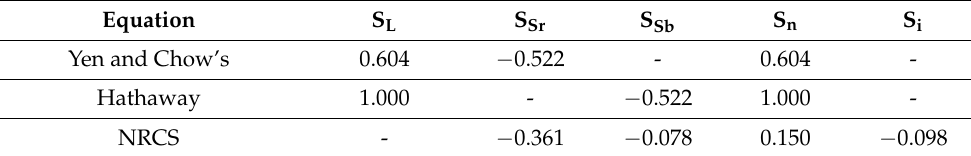
Table 11. Sensitivity coefficients of the methods based on n (category